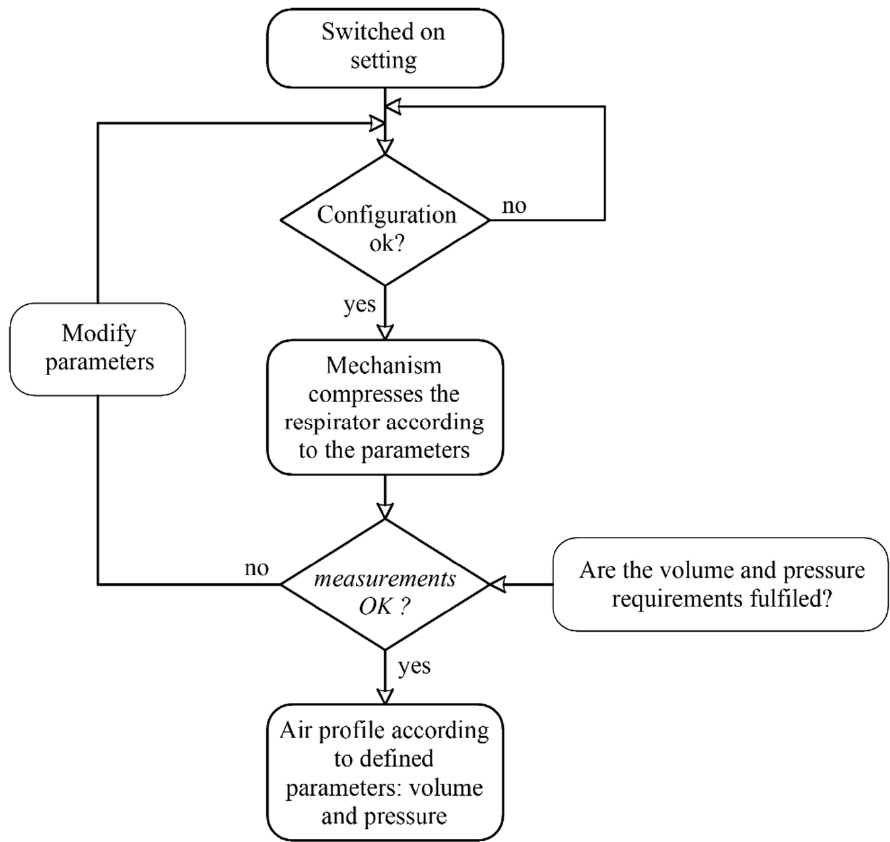
Figure 7. Flowchart